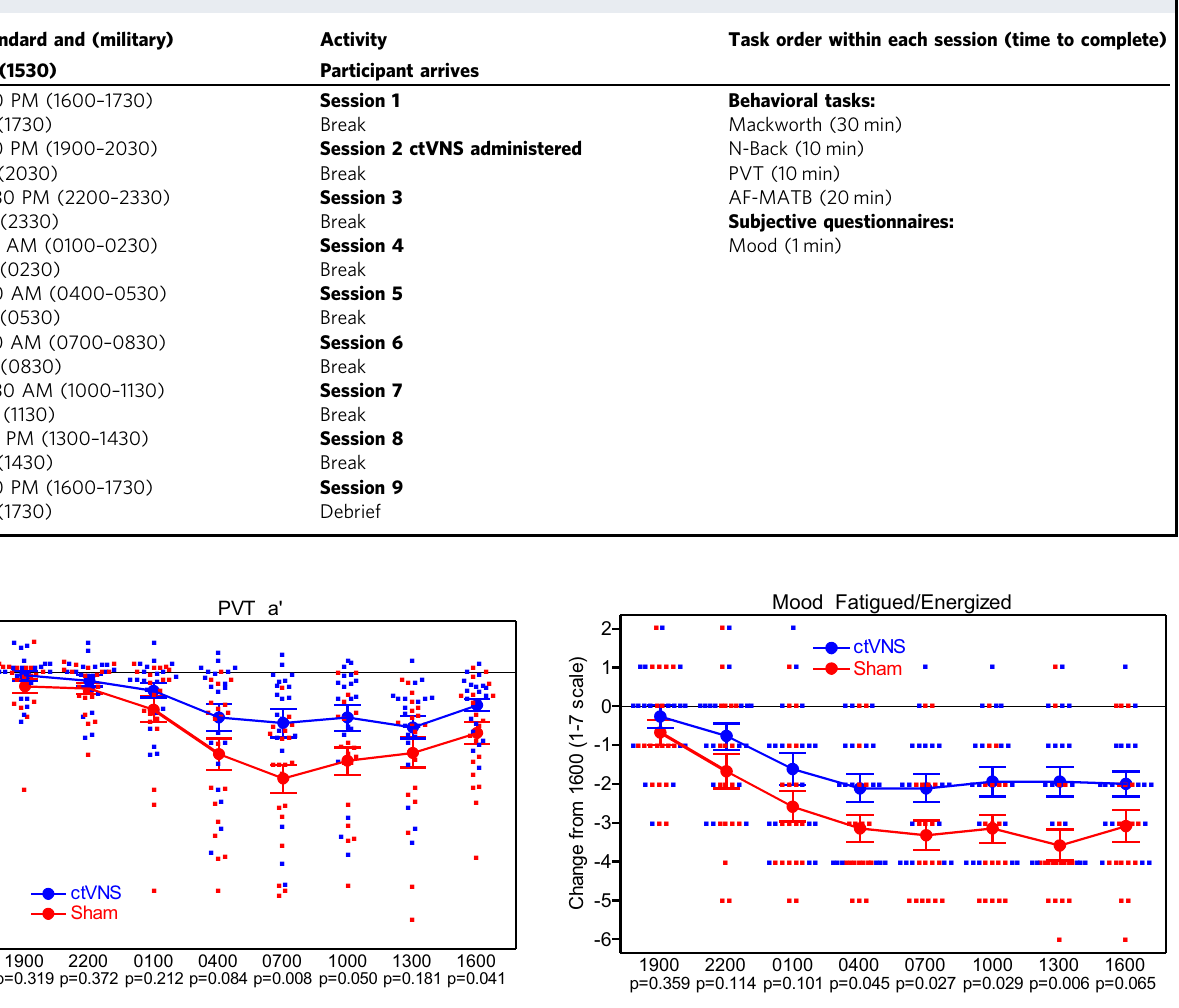
Fig. 2 PVT task a ’ metric as a change from 1600. PVT a prime metric as a change from 1600 with error bars that are mean + / −